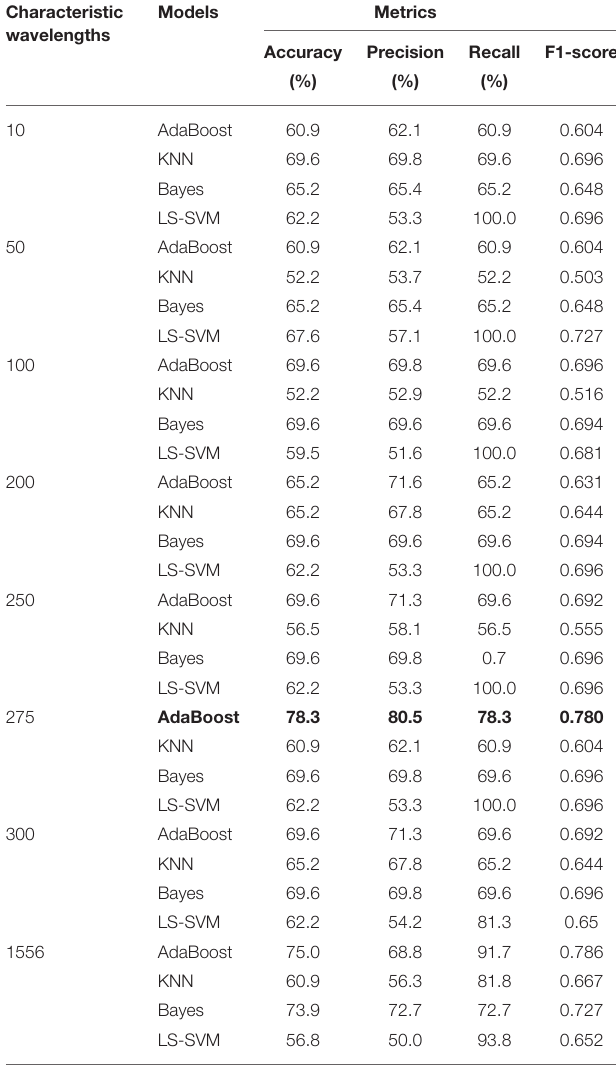
TABLE 1 | Modeling results of sweet (SSC beyond 9 Brix) and unsweet (SSC below 9 Brix) classification of Miyagawa Satsuma in Chongming Island under different classifiers with different characteristic